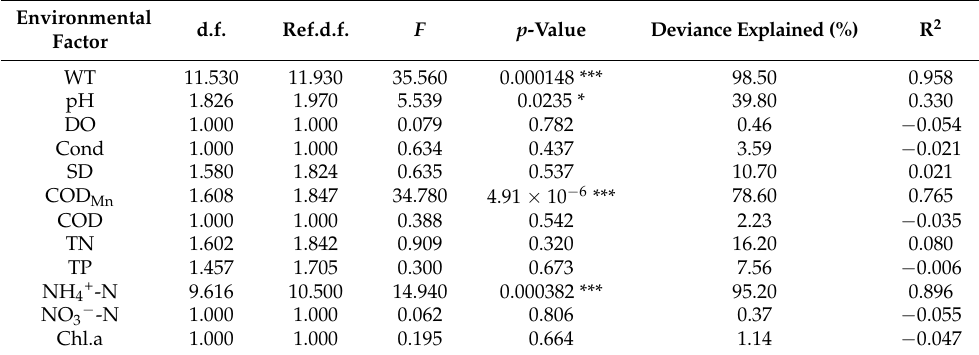
Table 2. GAM model analysis of TOC concentration and environmental factors in the Danjiangkou Reservoir in Autumn.